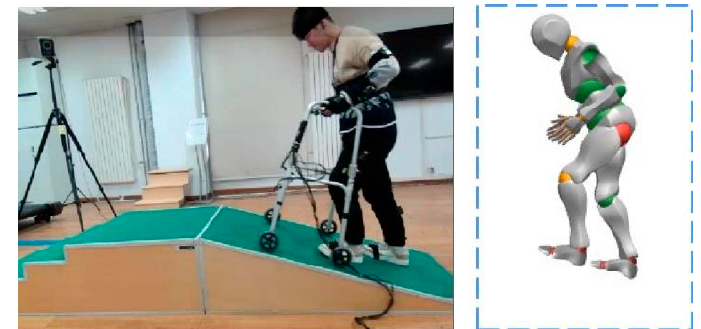
Figure 4. Data acquisition methods for the different experimental tasks.